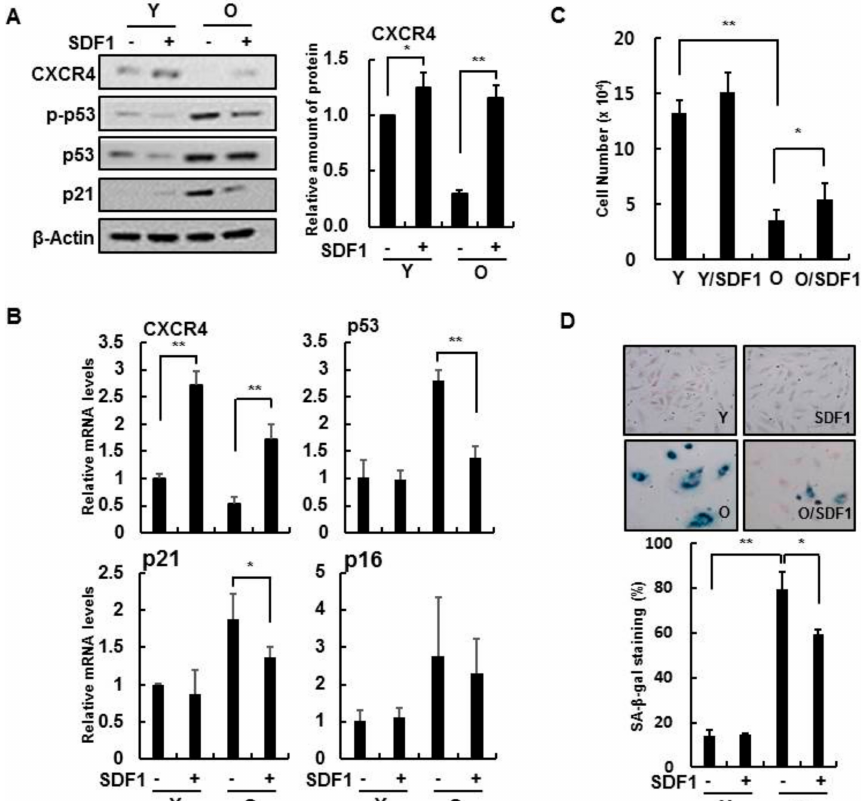
Figure 2. SDF-1 induces CXCR4 expression in senescent HBMVECs. ( A ) Young and old HBMVECs were treated with 50 ng / mL recombinant SDF-1 protein for 24 h. Protein levels of CXCR4, phospho-p53, p53, and p21 were determined via Western blotting. ( B ) In each cell, expression levels of CXCR4, p53, p21, and p16 were measured using real-time polymerase chain reaction analysis. ( C ) To measure cell proliferation, the cells were treated with 50 ng / mL SDF-1 for 4 days, and the number of cells was counted. ( D ) Cells were stained for SA- β -gal activity and evaluated using a light microscope (100 × ). senescence-associated beta-galactosidase (SA- β -gal) positive cells were analyzed and expressed as a percentage. Values are expressed as the mean ± standard deviation of three independent